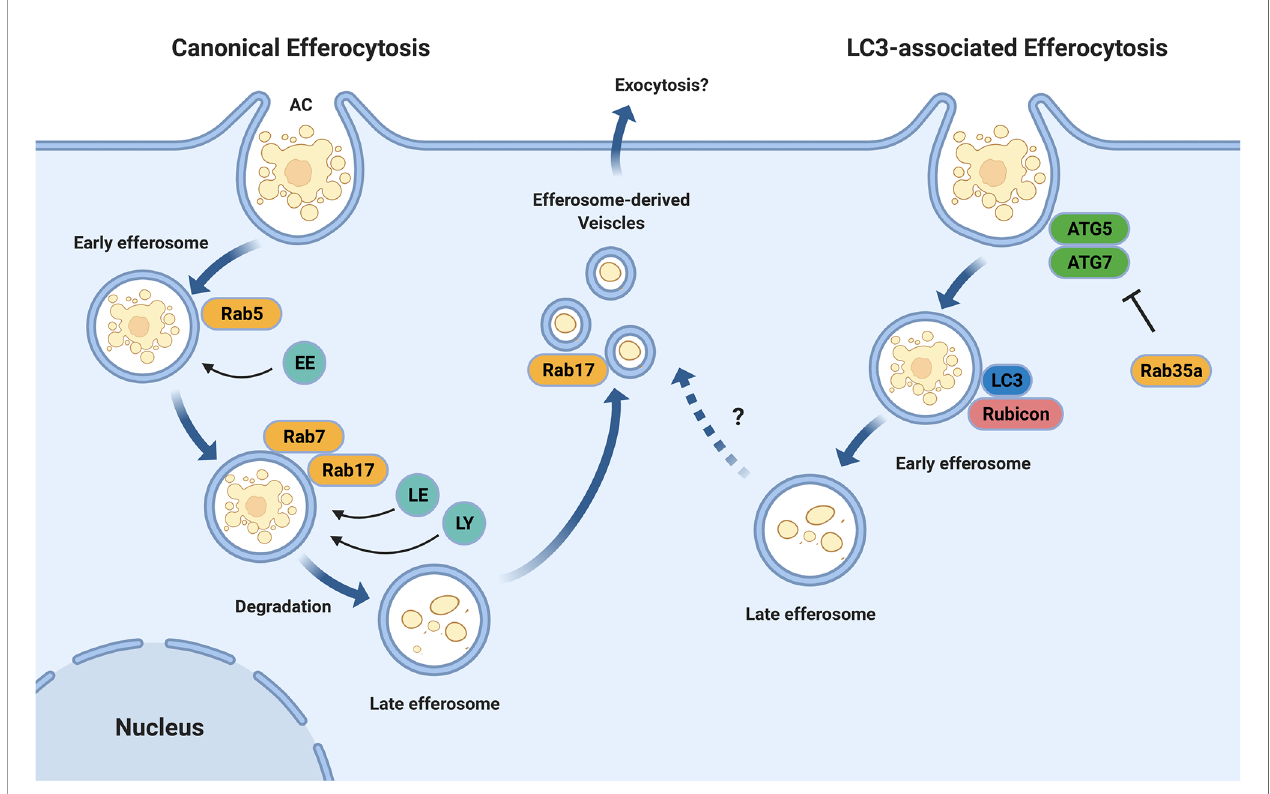
FIGURE 1 | Efferosome Maturation Pathways. Efferocytosis can occur through the canonical endo-lysosomal maturation pathway (left) in which the GTPases Rab5 and Rab7 mediate the sequential fusion of early endosomes (EE), late endosomes (LE), and lysosomes (LY) with the maturing efferosome. Unlike phagocytosis, this efferosome maturation pathway also involves Rab17 which directs the degraded contents from the efferosome to the recycling endosome from where they may be exocytosed, thereby avoiding the delivery of these materials to antigen loading compartments. In addition to the canonical pathway, some efferosomes may mature through an LC3-mediated, autophagy-like pathway (right). In this pathway, the efferosome recruits the protein LC3 which then mediates a rapid degradation of the efferosome in a fashion which suppresses antigen presentation. Similar to LC3-associated phagocytosis, the recruitment of the autophagy-related proteins ATG5 and ATG7, as well as Rubicon to the nascent efferosome appear to be important for efferocytosis through this pathway. The activity of ATG5 and ATG7 are inhibited by Rab35a, which is activated downstream of TLR signaling. Figure produced using